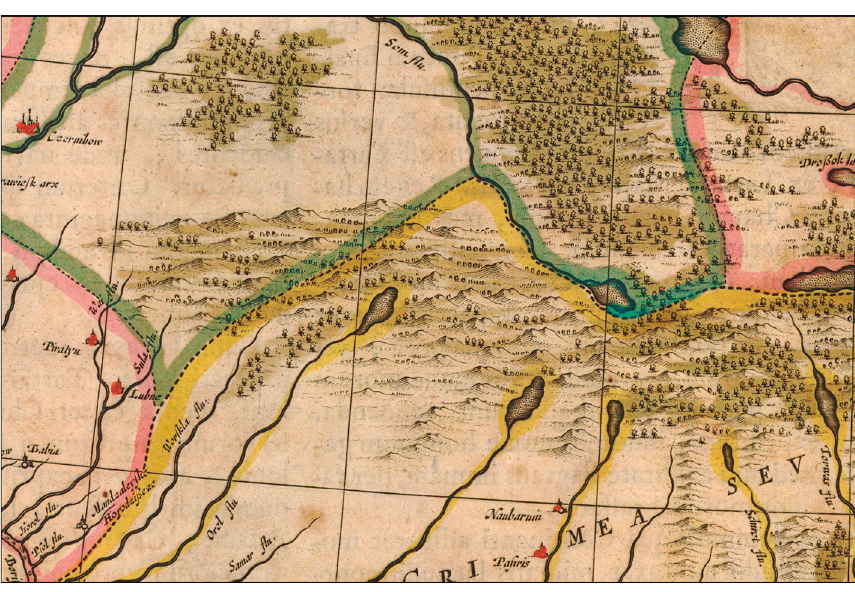
Fig. 6. Part of the map of Taurica Chersonesus by W.J. Blaeu (1641)